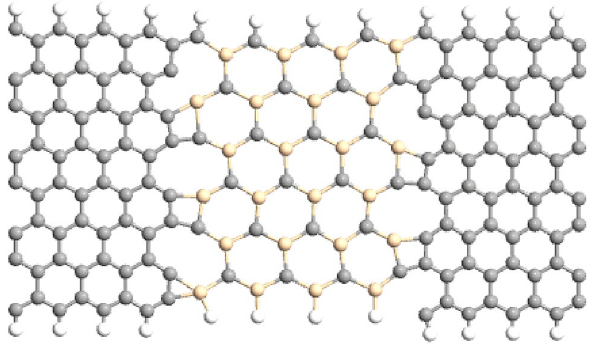
Figure 1. The optimized geometry of the silicon carbide nanoribbon between the GNRs. Carbon (silicon) atoms are represented by gray (yellow) circles